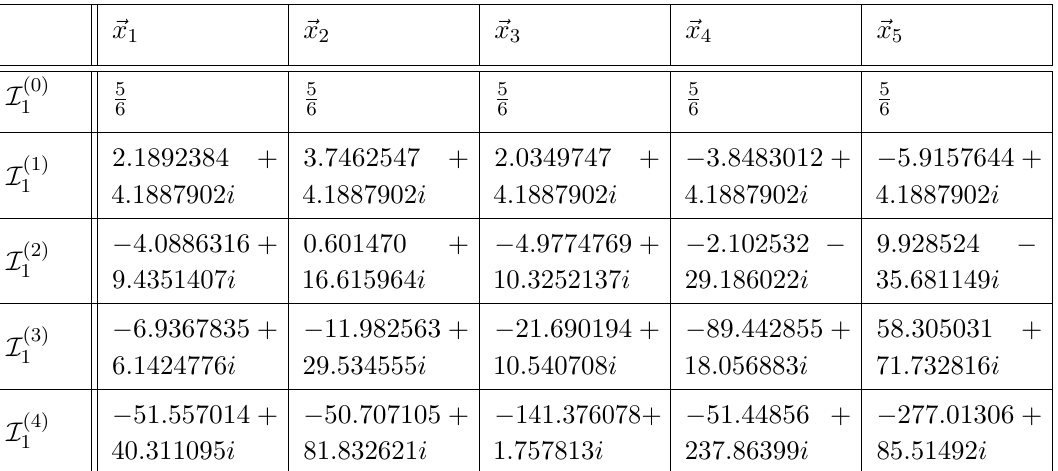
Table 1 . Benchmark points for the pentagon-box master integrals I 1 . I ( k )